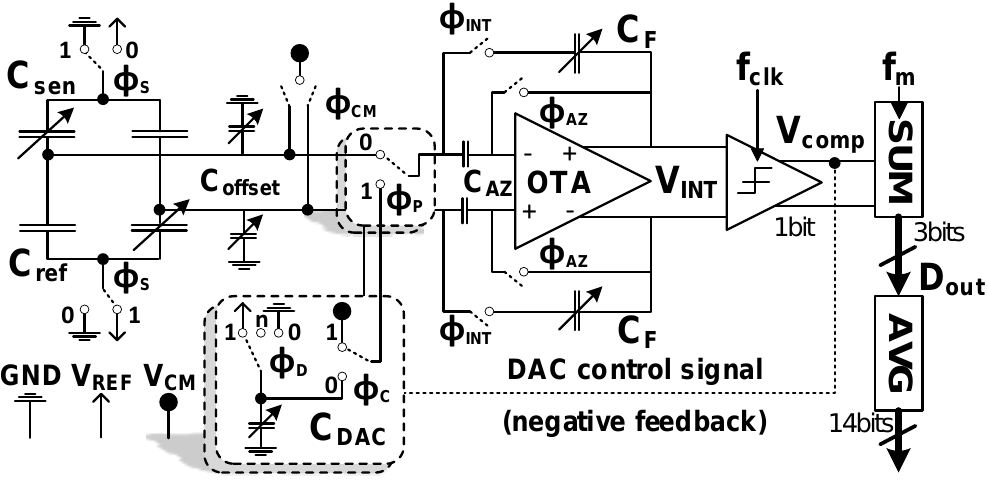
Figure 8. Implemented fully differential Switched-Capacitor direct CDC. Note: DAC and φ P have single-ended representation for more